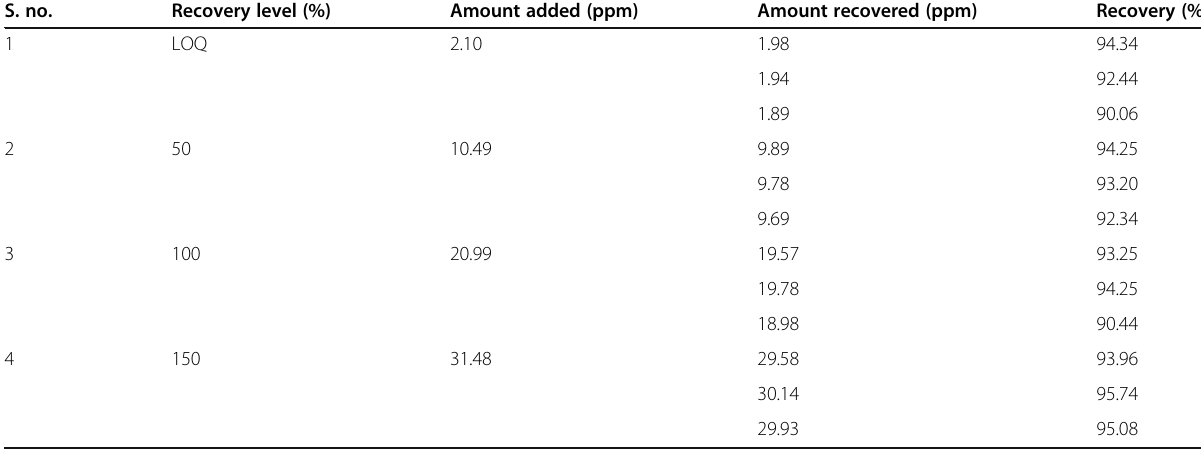
Table 16 Results of recovery study for DIPEA S.